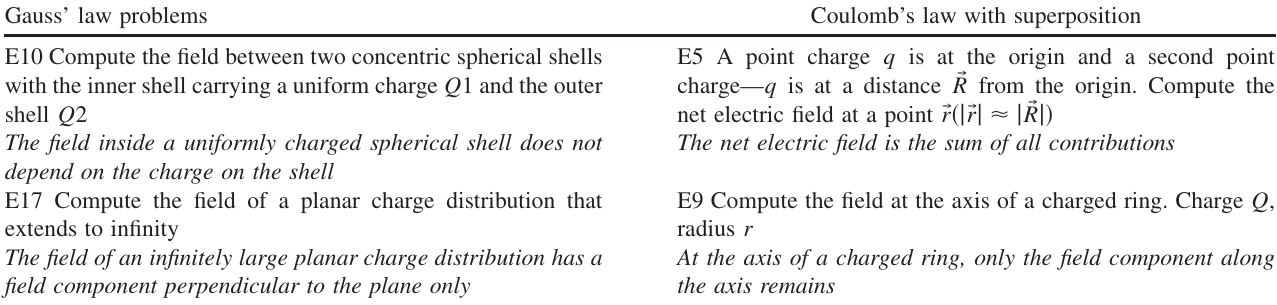
TABLE III. Examples of electricity problems from two different problem categories. Note that for each problem there was an elaborated version and a nonelaborated version. The nonelaborated version only gave the normal printed text, the elaborated version also gave the italicized text.